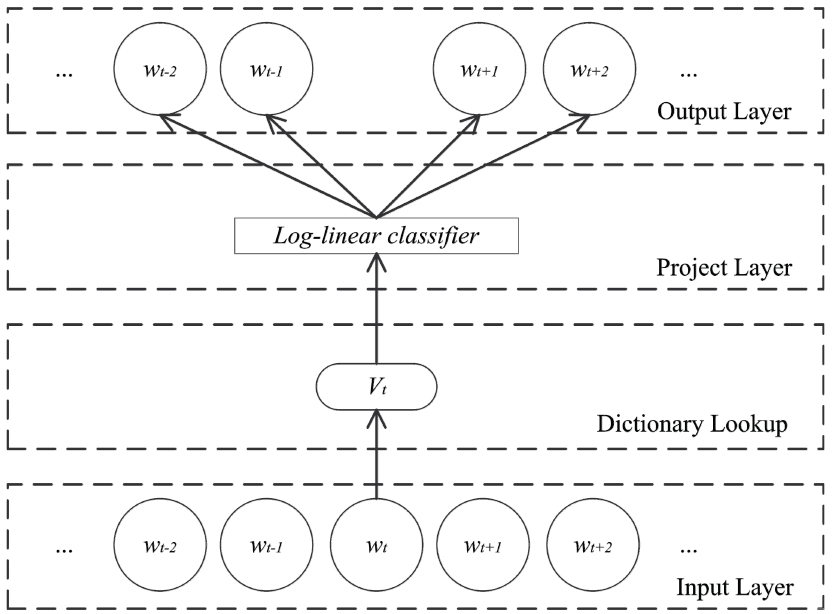
Figure 3. Architecture of the skip-gram